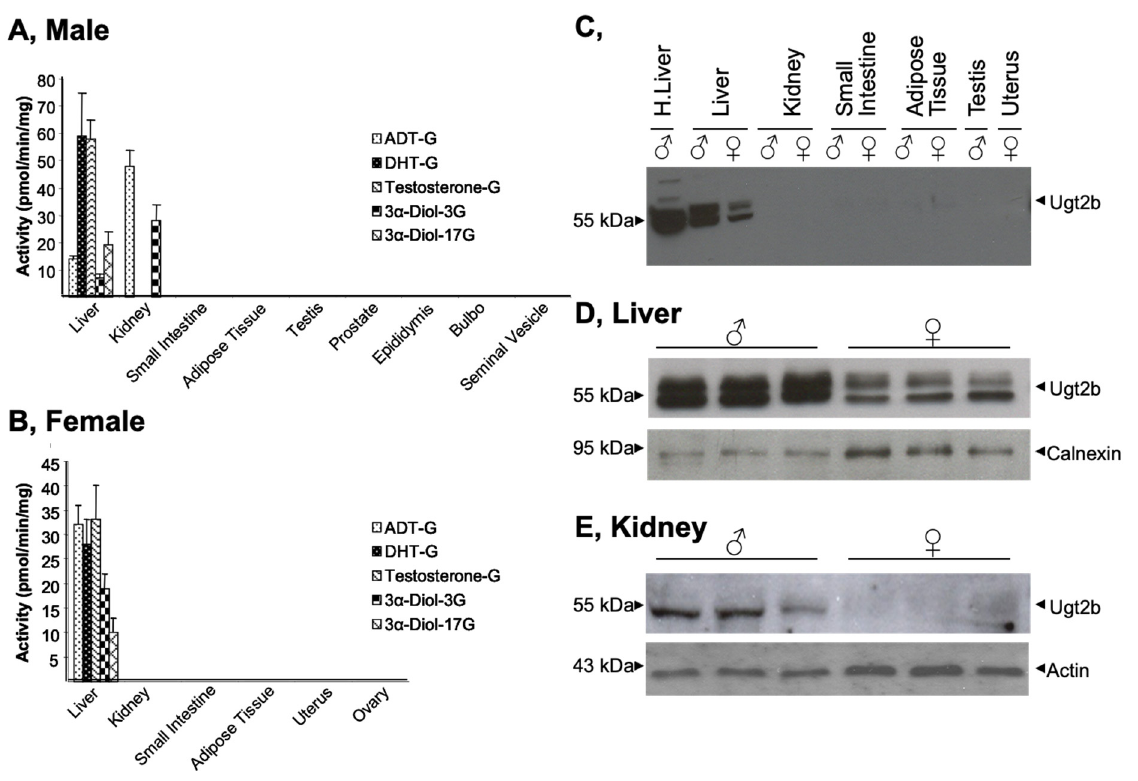
Figure 1. Tissue- and gender-specific distribution of Ugt2b expression and androgen-conjugating activities in mice. ( A , B ) Glucuronidation assays were performed with homogenates (40 µg) of male ( A ) and female ( B ) murine tissues in the presence of 100 µM of androgens for 1 h. Assays were performed in triplicates with tissues from three animals. The formation of androgen glucuronides was quantified by LC–MS/MS analyses. ( C – E ) Tissue homogenates (40 µg, ( C )) or microsomal proteins (5 µg; ( D , E )) were size-separated on 10% SDS-PAGE, transferred onto nitrocellulose membranes and hybridized with an anti-UGT2B (EL-93, 1/2000) antibody. ( D , E ) Membranes were subsequently immunoblotted with an anti-calnexin (( D ), 1/2000) or an anti-actin (( E ), 1/5000) antibody to ensure an equal loading of proteins in each lane. ADT: androsterone; DHT: dihydrotestosterone; 3 α -Diol: androstane-3 α , 17 β -diol. Full western blot are provided as supplementary Figure S1.